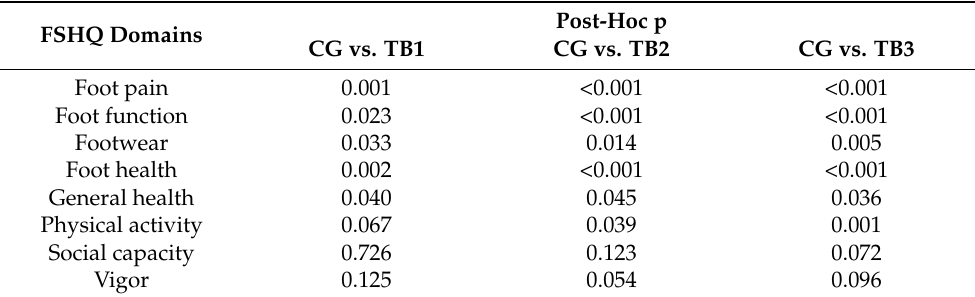
Table 7. Systematic differences between Foot Health Status Questionnaire and patients with different classifications of tailor’s